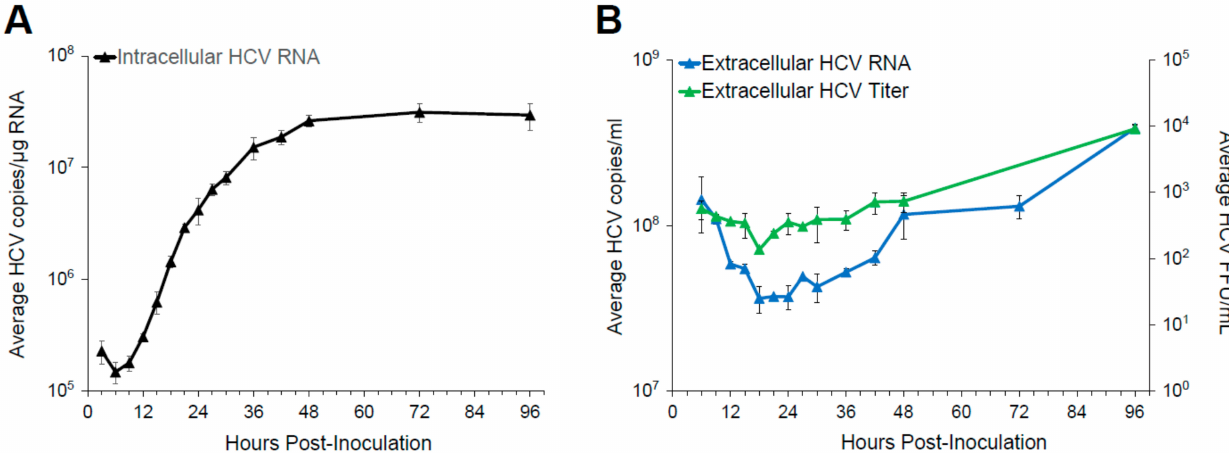
Figure 1. HCV High MOI Infection Kinetics: Huh7 cells were infected with HCV at an MOI of 6. Cell lysates and culture media was harvested at the indicated time points. ( A ) Intracellular HCV RNA (black triangles). HCV and cellular GAPDH RNA levels were quantified by RT-qPCR. Cellular GAPDH was used to normalize HCV copies, which are then graphed as average HCV copies/ µ g RNA in triplicate samples +/ − standard deviation (SD). ( B ) Extracellular HCV RNA (blue triangles) are graphed as average HCV copies/mL. HCV titers (green triangles) are graphed as foci-forming units (FFU)/mL. Pooled culture media samples from the triplicate wells were spiked with equal amounts of mouse liver RNA as an internal control before extracellular RNA was extracted. Extracellular HCV RNA and mouse GAPDH (mGAPDH) RNA levels were quantified by RT-qPCR. HCV copies were normalized to mGAPDH and graphed as average HCV copies/mL in duplicate samples +/ − SD. Titers were determined by titrating the pooled media on naïve Huh7 cells. Results are the average of foci counted in three wells +/ −